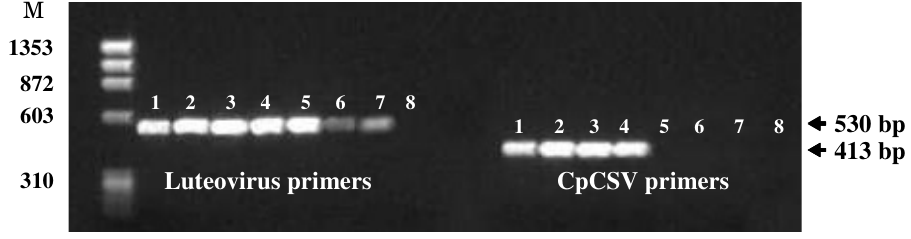
Fig. 2. Detection of Chickpea chlorotic stunt virus (CpCSV) from Eritrea by RT-PCR using Luteovirus (Lu Lu +Eco) (left) and CpCSV (right) primers. 1-4, CpCSV isolate from Eritrea; 5, Beet western yellows virus ; 6, Bean 4 leafroll virus ; 7, Soybean dwarf virus ; 8, negative control; M, DNA molecular weight markers ladder (IX, from Roche, Cat no. 1449 460).